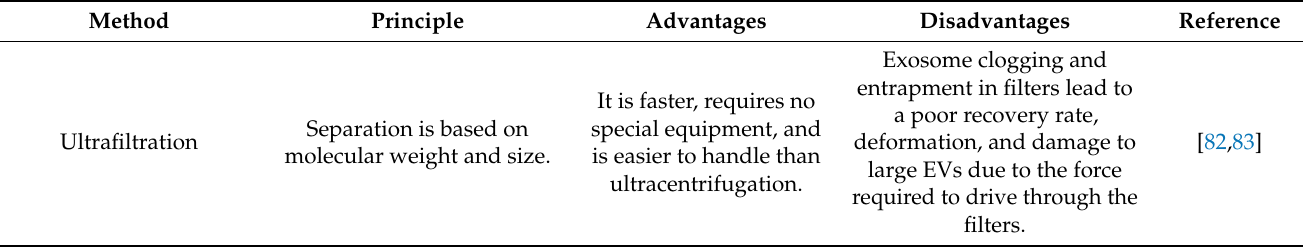
Table 2. Principles, advantages and disadvantages of exosome separation methods